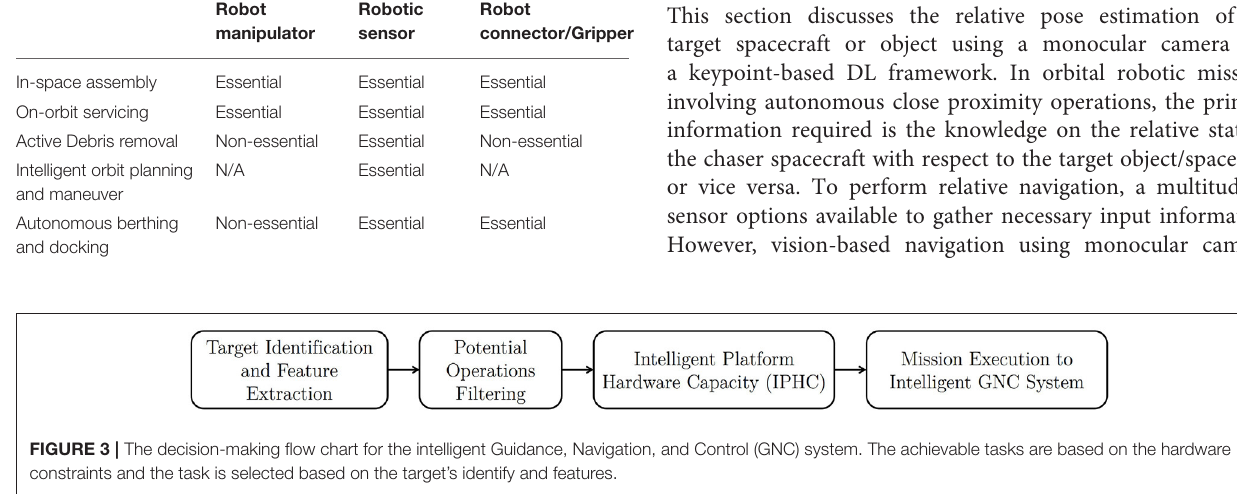
Frontiers in Robotics and AI |